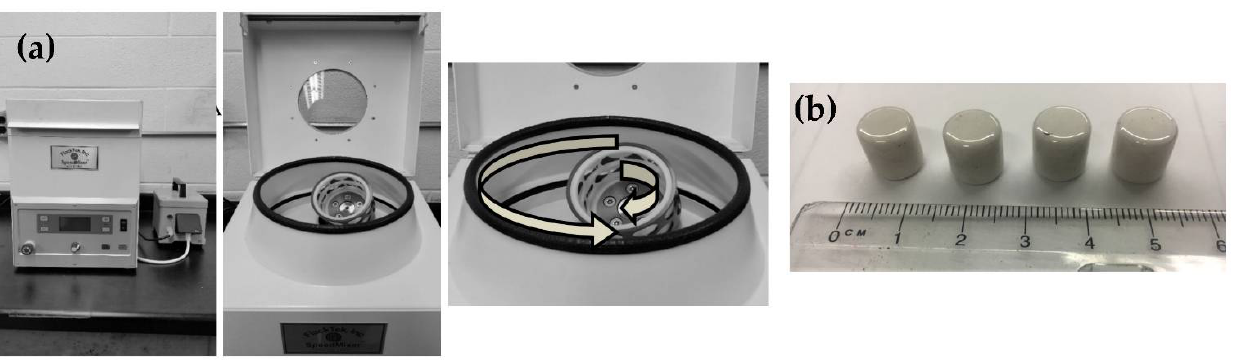
Figure 1. ( a ) FlackTek SpeedMixer DAC 150.1 FVZ; ( b ) Zirconium cylinders used for mixing media in SpeedMixer.